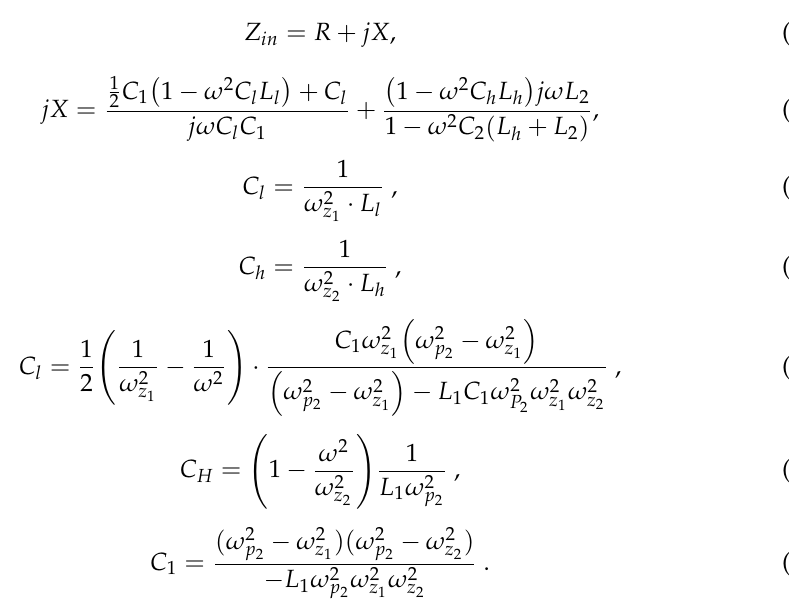
Figure 2. Equivalent circuit model of the original antenna.